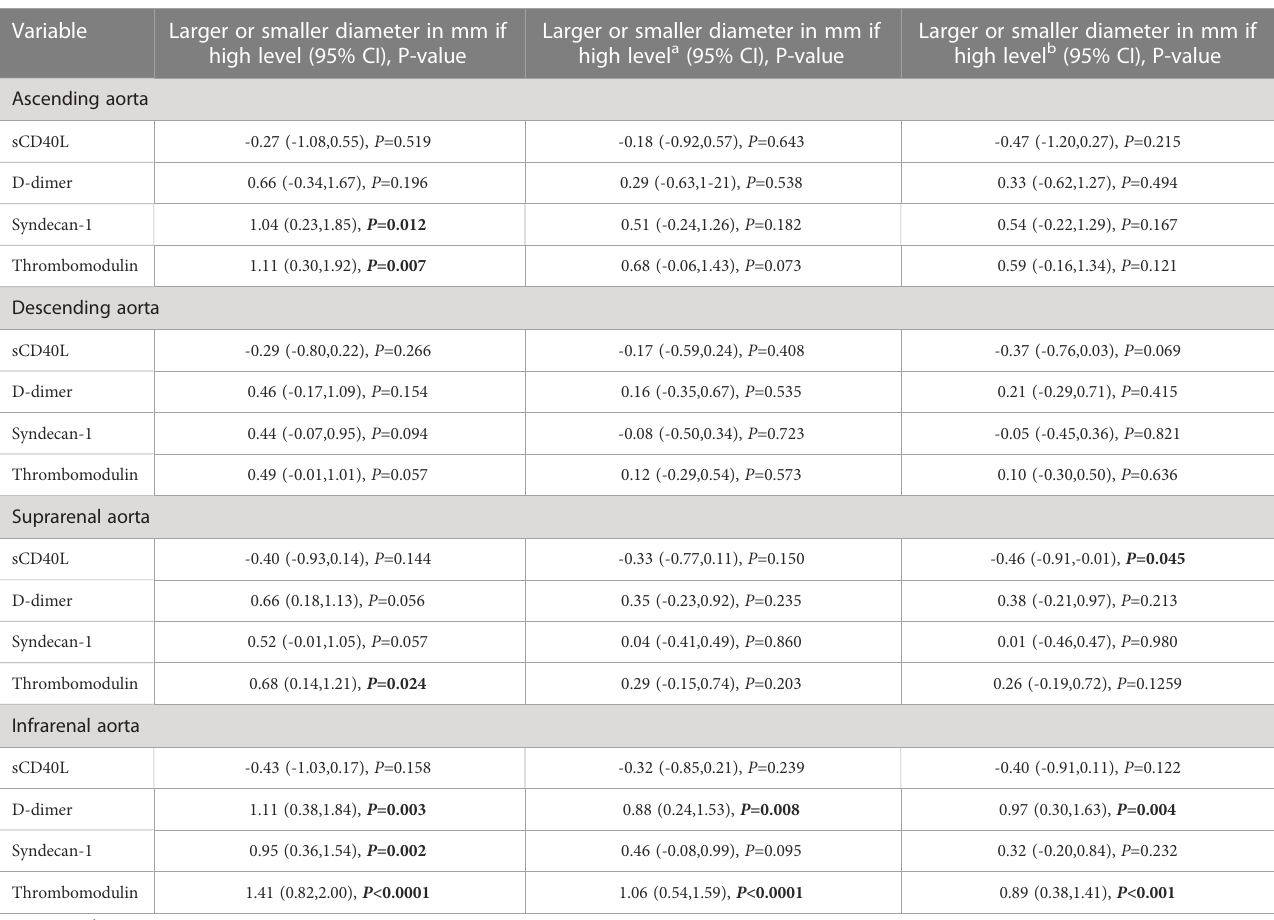
TABLE 4 Associations between aortic diameter and the biomarkers.